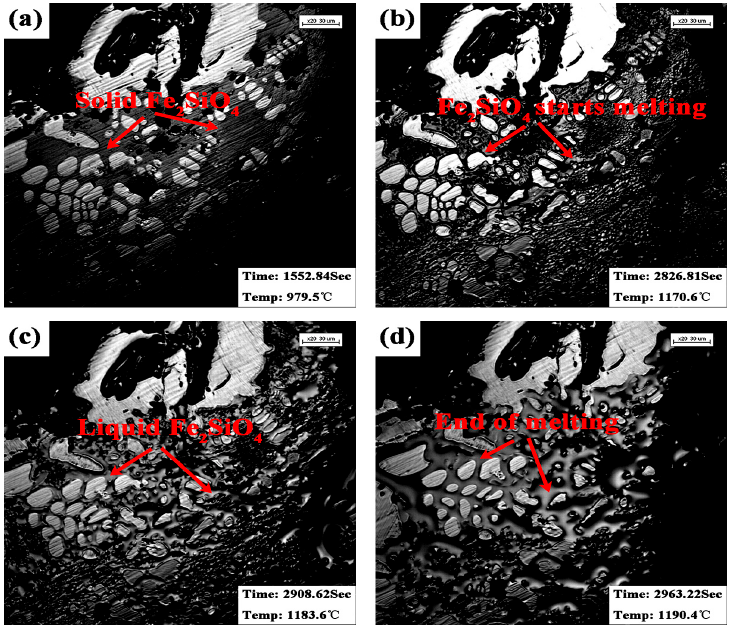
Figure 6. Micrographs showing results from in situ observations of the melting process of Fe 2 SiO 4 for steel SiP ‐ 1 ( a ) before melting; ( b ) at the start of melting; ( c ) during melting; ( d ) at the end of melting.